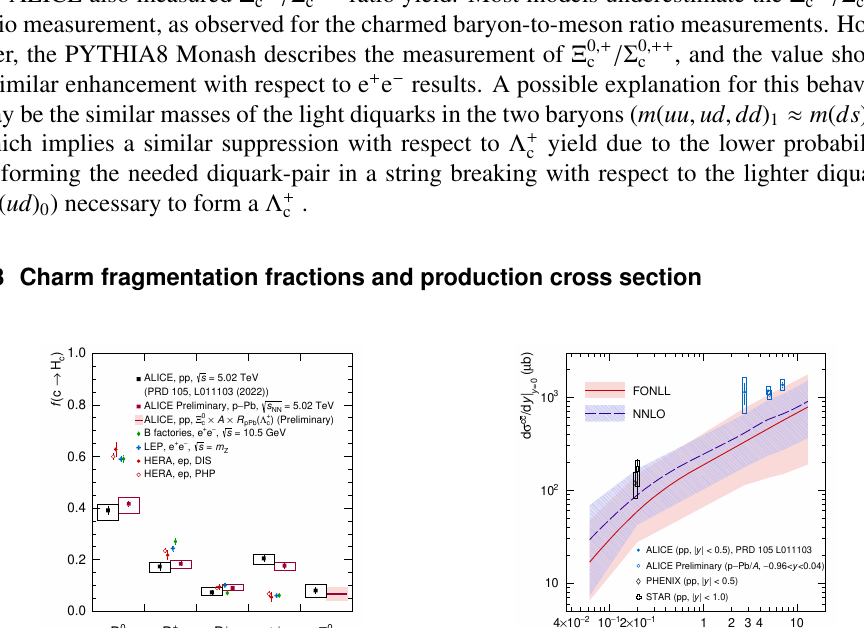
T in pp collisions at